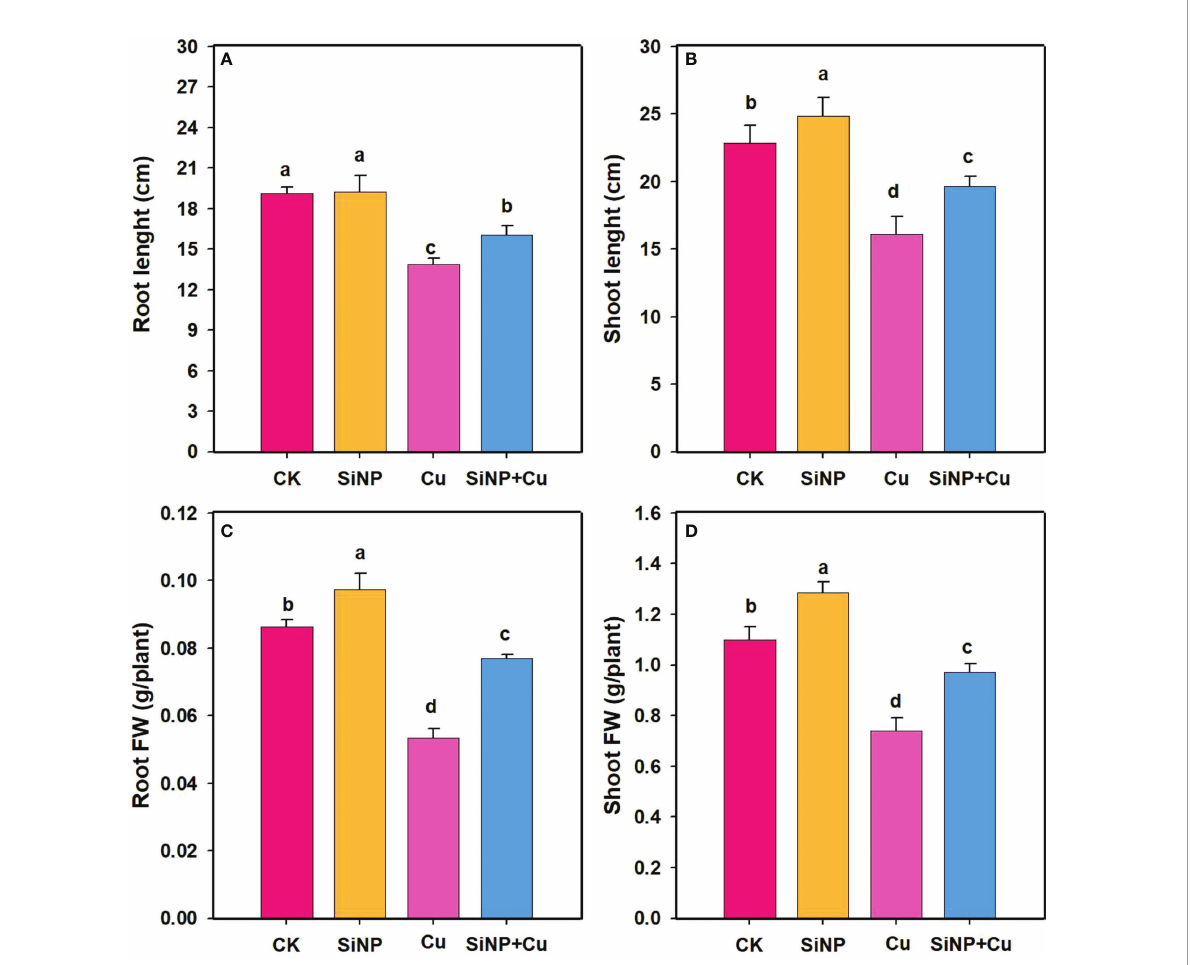
FIGURE 1 The growth characters of wheat seedlings under Cu 2+ stress. Note “ Experimental treatments contained: CK (Control); SiNP (2.5 mM SiNPs); Cu 2+ (500 µM Cu 2+ alone), SiNP+Cu 2+ (2.5 mM SiNPs+500 µM Cu 2+ ). The different letters (a, b, c, d) above bars describe the differences in different treatments by LSD test at (P ≤ 0.05) ” . (A) root length, (B) shoot length, (C) root FW, (D) shoot